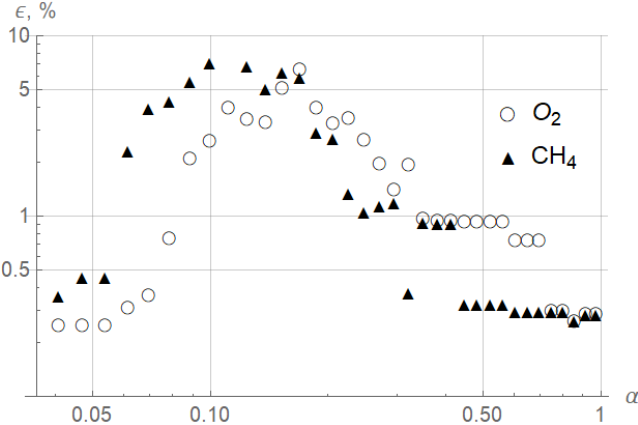
Figure 5. Mass flow rate